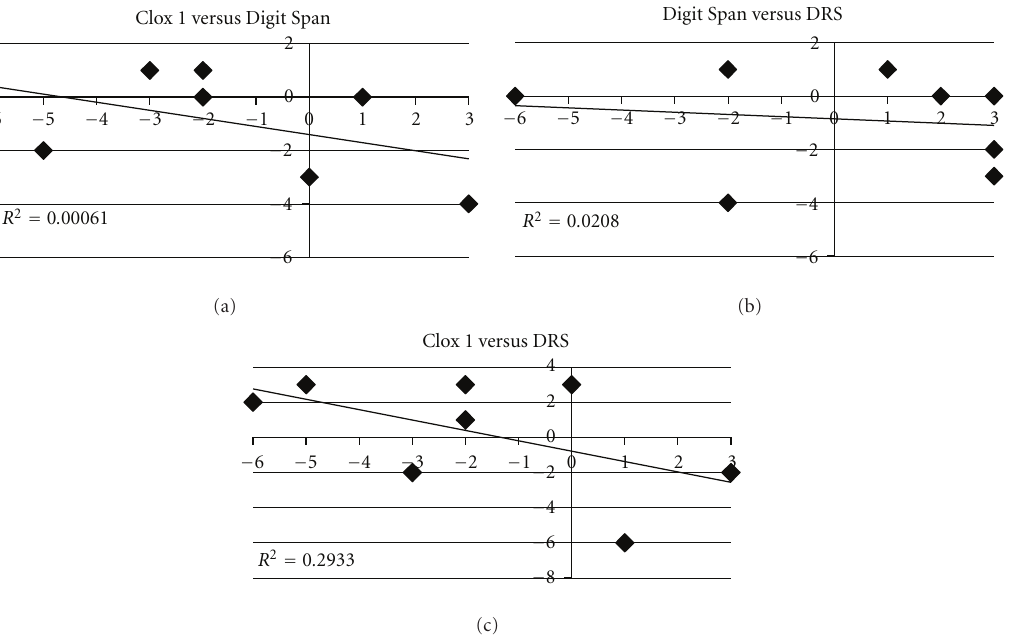
Figure 2: Comparison of individual performance on Clox 1, the WAIS Digit Span and the DRS Each individual’s performance on one test was plotted as a function of the other, and a regression line was determined.